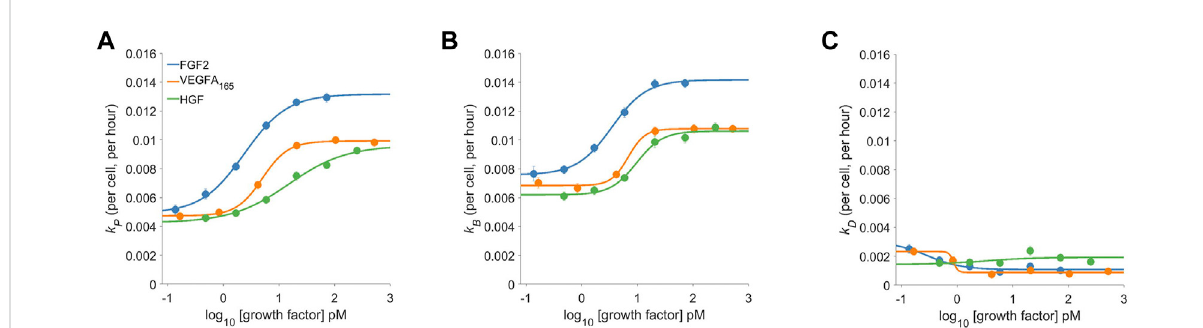
FIGURE 3 The dose-response proliferative behavior of Dermal Microvascular Endothelial Cells (DMECs) to Three Pro-Angiogenic Growth Factors. The proliferationrate (A) ,thebirthrate (B) ,andthedeathrate (C) forFGF2,VEGFA,andHGFoverarangeofconcentrations.Notethatthe y -axessharethe same scale to facilitate comparison of the relative magnitude of